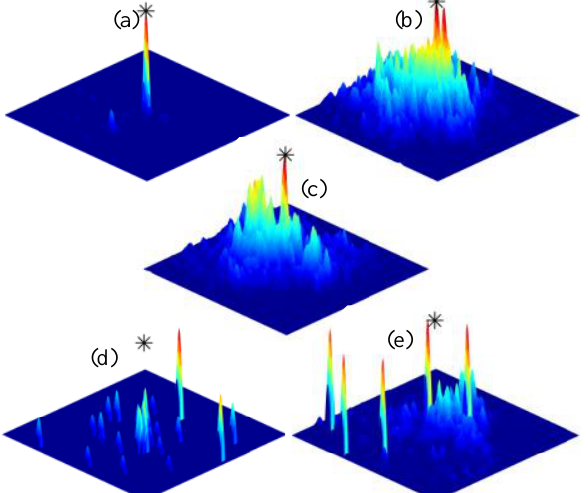
Figure 8. Centre voting for S8 ( a ) for the proposed RV-GHT, ( b ) the GDP-GHT, ( c ) the PI-GHT, ( d ) the GFGHT, and ( e ) the FRGHT under the configuration of rotation = 53 ◦ and scaling = 0.73. The ground truth centre is labelled as a black star near the peak.